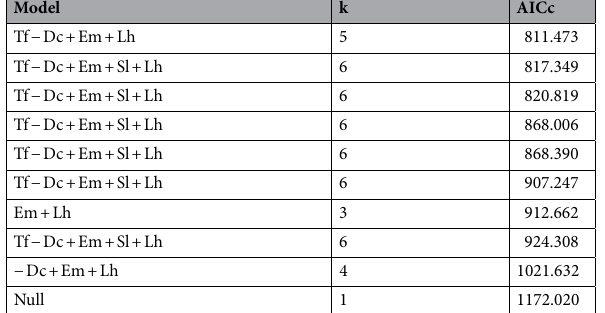
Table 5. Results of GLMMs explaining variation in hare–vehicle collision points and random points without collisions in the study area. Tf traffic volume, Dc distance to nearest cross, Em presence of embankment, Sl speed limit, Lh landscape heterogeneity, k number of parameters, AICc Akaike information criterion corrected for small sample sizes.